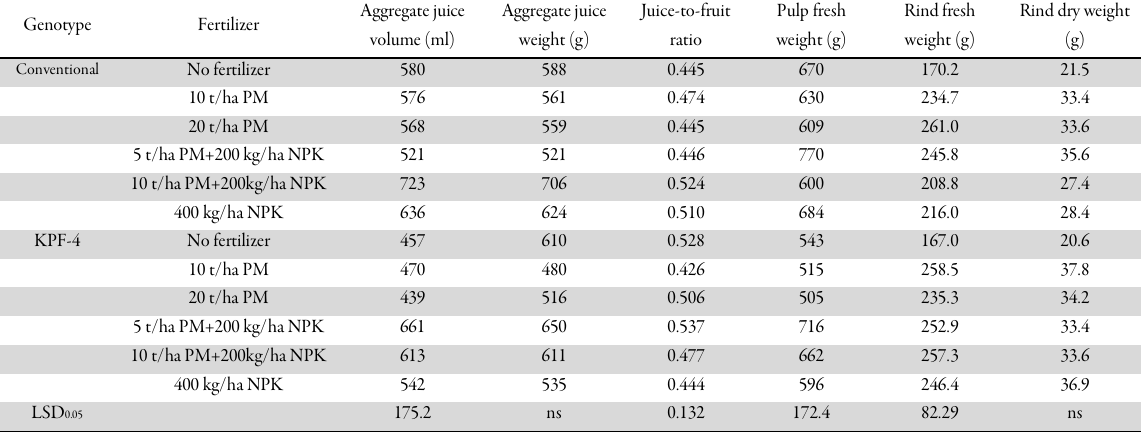
Table 9. Combined effect of genotype and fertilizer on some fruit and juice metric traits of yellow passion fruit grown in the field in 2017